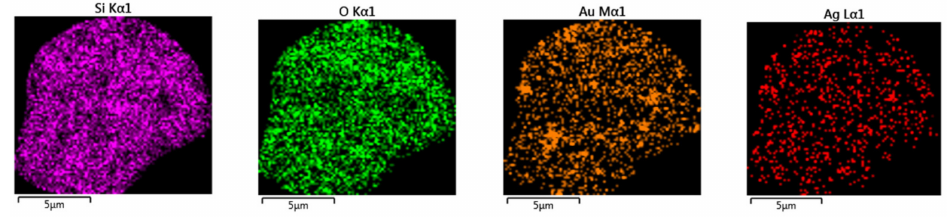
Figure 18. EDS mapping for the Au/Ag//SiO 2 composite from the macromolecular Chitosan · (AuCl 3 /AgSO 3 CF 3 ) n · SiO 2 precursor 1:1. Adapted from reference